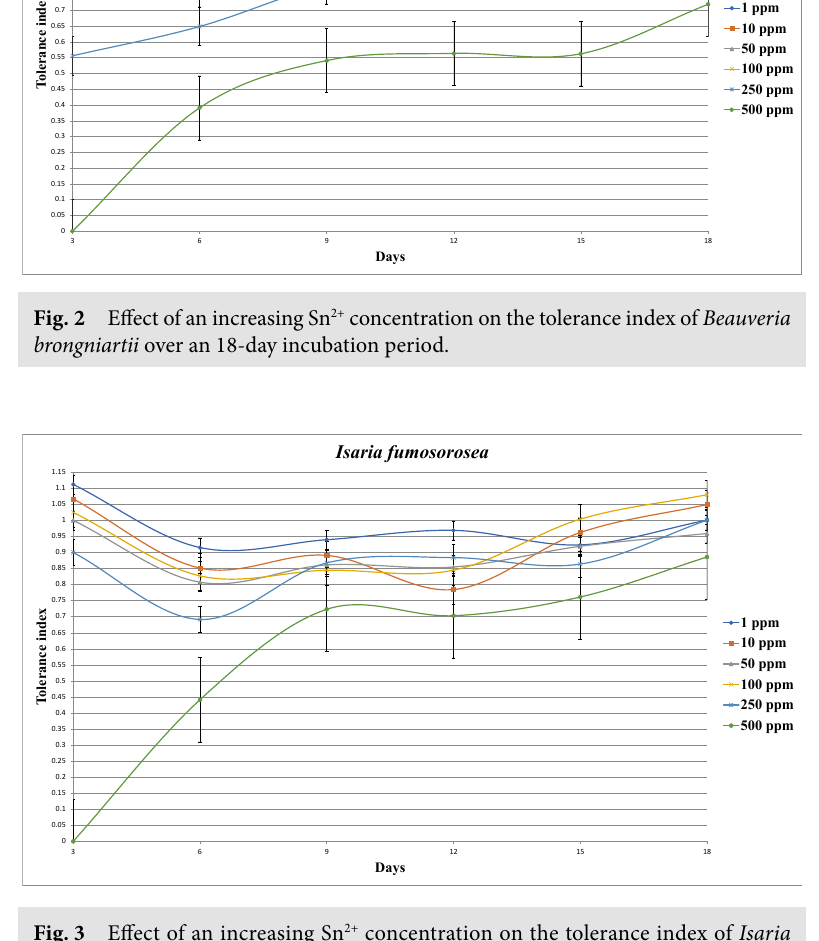
Fig. 3 Effect of an increasing Sn 2+ concentration on the tolerance index of Isaria fumosorosea over an 18-day incubation